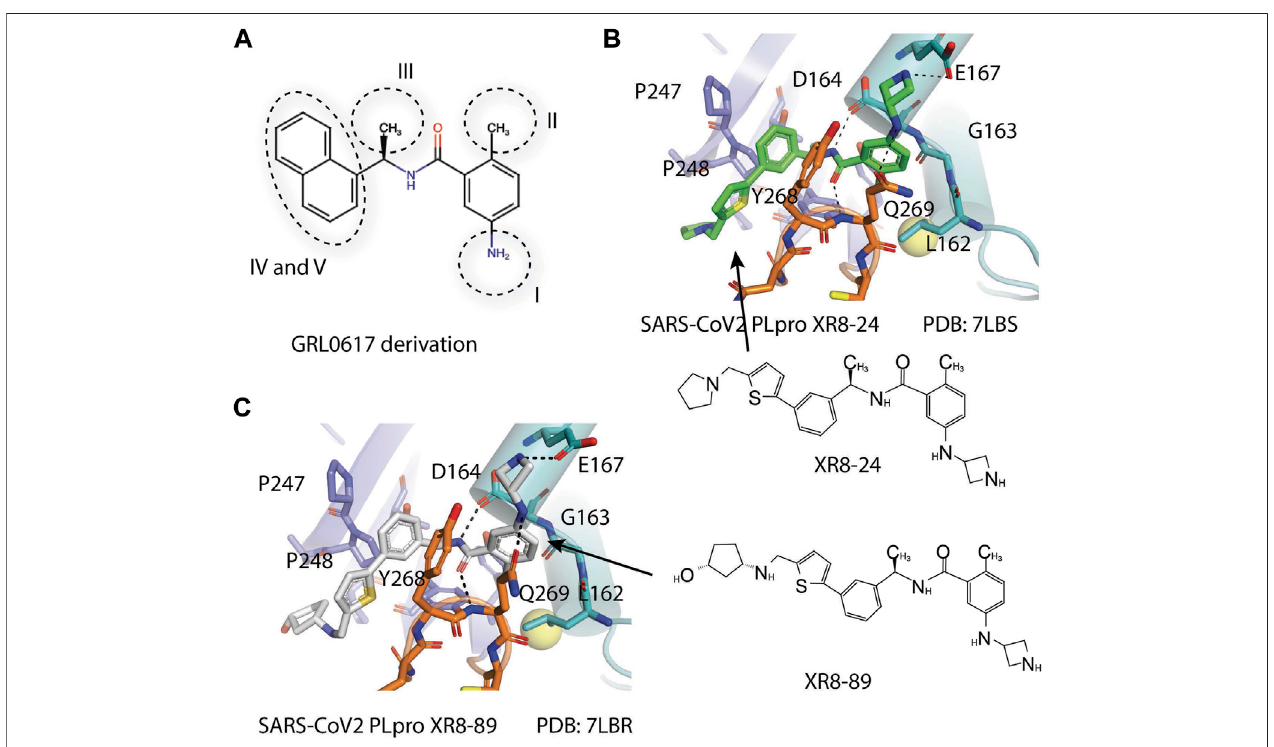
FIGURE5|(A) Fiveregionsthatwerederivatized forre fi nement ofGRL0617. (B and C) Close-upviewofinteractionbetweenSARS-CoV-1PLproandinhibitors in crystal structures. PLpro is shown as cartoon with sticks representation shown for residues involving contact with inhibitors. Inhibitors are shown as sticks. Hydrogen bonds were labeled with dashed lines. (B) SARS-CoV-2 PLpro with XR8-24 (PDB: 7LBS). (C) SARS-CoV-2 PLpro with XR8-89 (PDB: 7LBR).